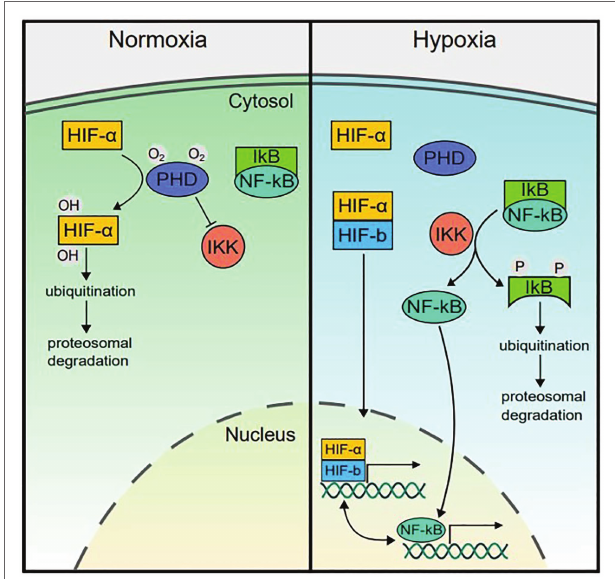
FIGURE 1 | Hypoxia inducible factor (HIF)-nuclear factor (NF)-kappa B